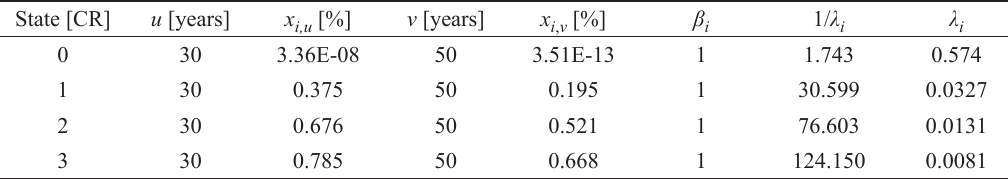
Table 5. Input parameters for the Markov process with Weibull distribution State